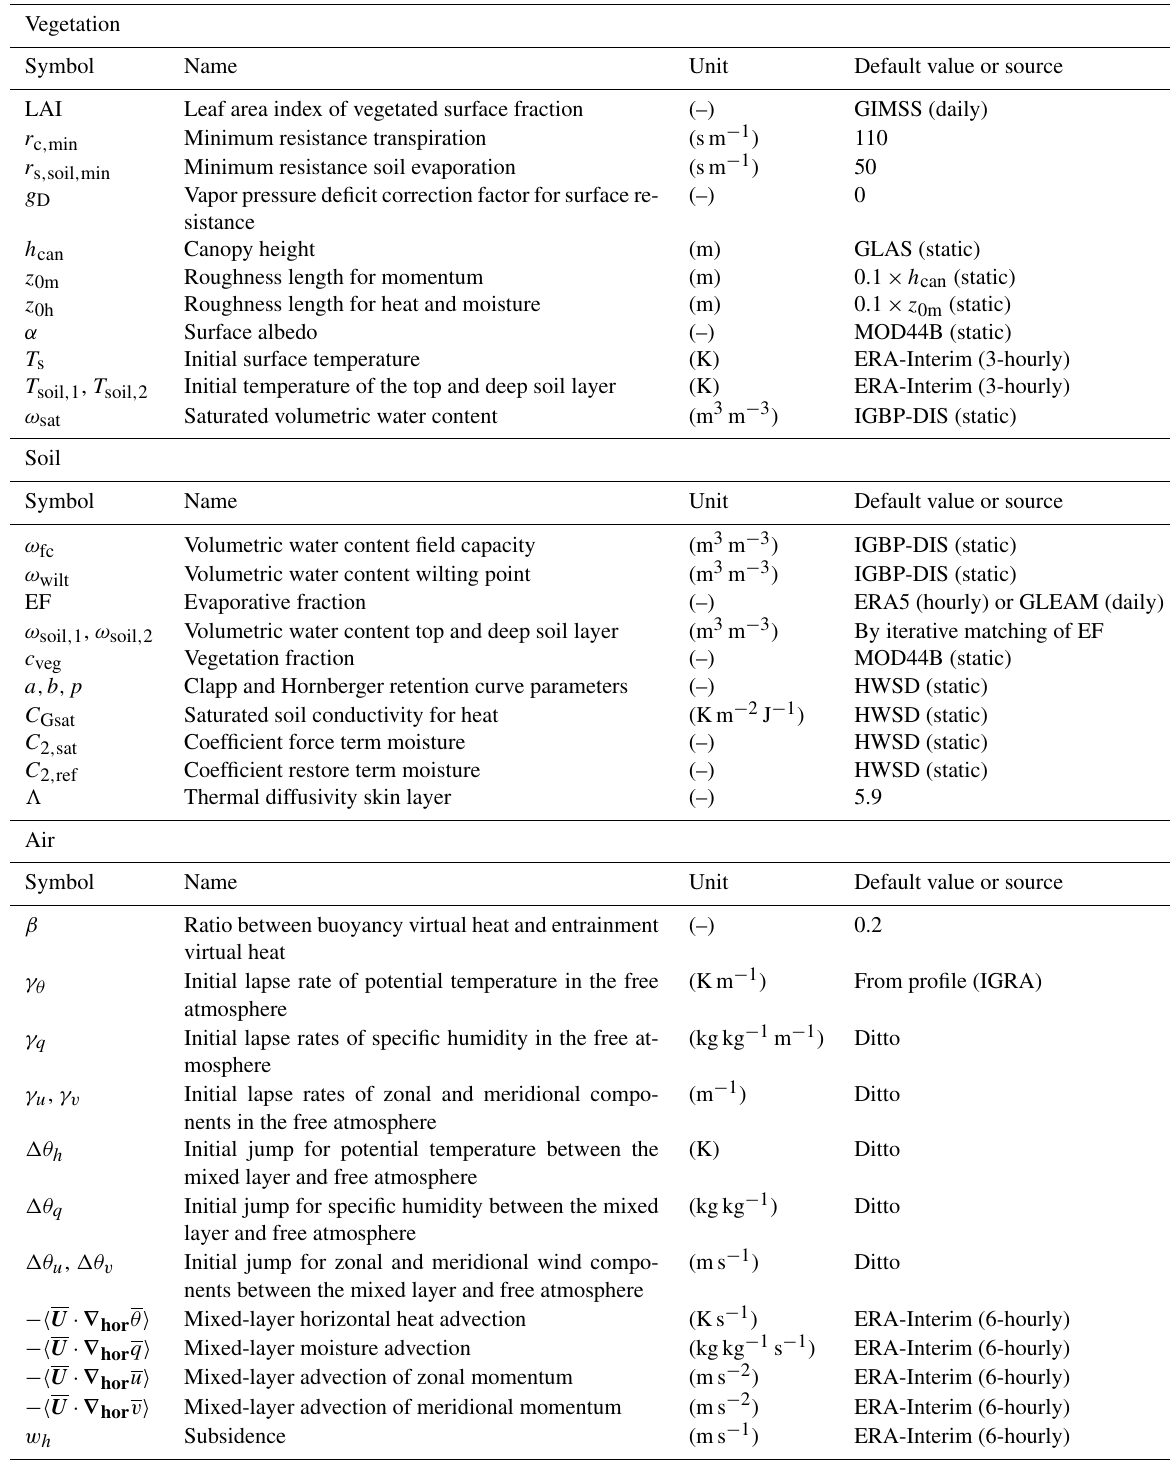
Table 2. Main input parameters for CLASS4GL. The parameter specifications and source acronyms are explained in Sect. 2.3 and Table 1.